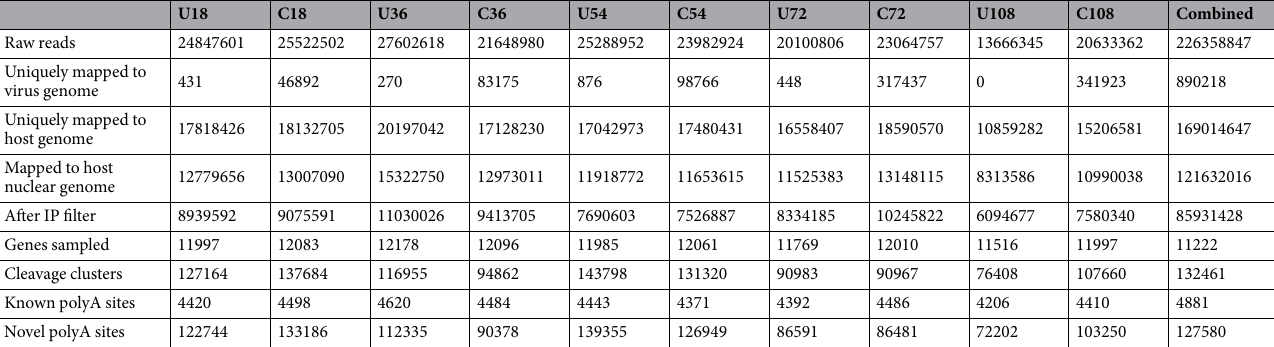
Table 1. Summary of SAPAS data from Illumina sequencing.